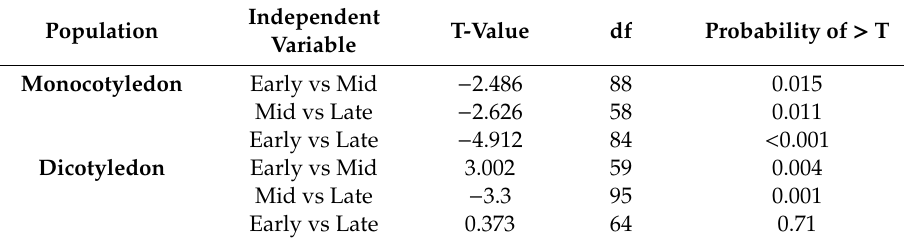
Table 4. Welch’s two-sample t-test 1